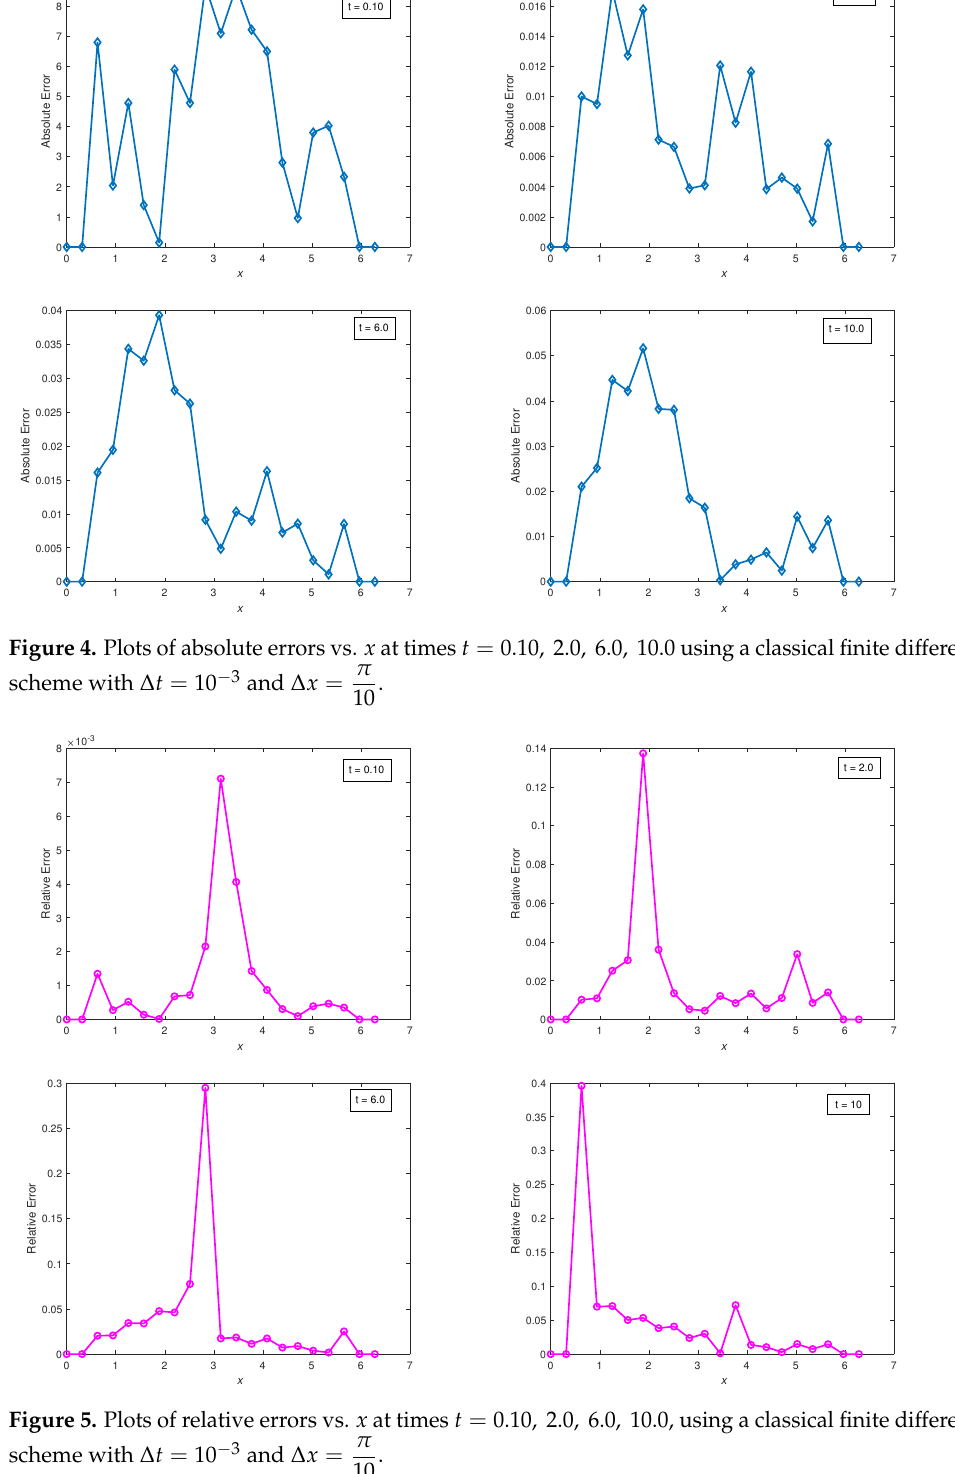
Figure 5. Plots of relative errors vs. x at times t = 0.10, 2.0, 6.0, 10.0, using a classical finite difference π scheme with ∆ t = 10 − 3 and ∆ x =